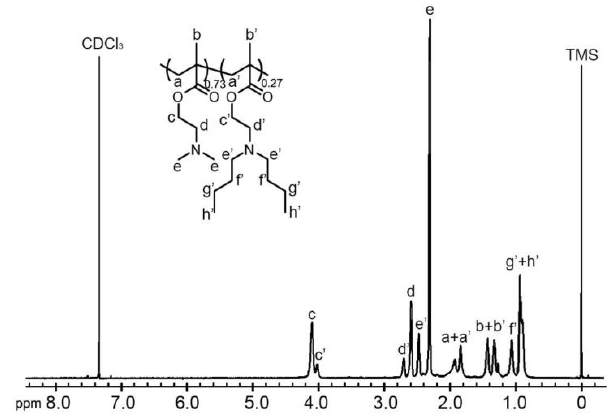
Figure 1. Proton nuclear magnetic resonance ( 1 H-NMR) spectrum of poly(2-(dimethylamino)ethyl methacrylate)- co -2-(dibutylamino)ethyl methacrylate) (P(DMAEMA 0.73 - co -DBAEMA 0.27 ) in CDCl 3 .